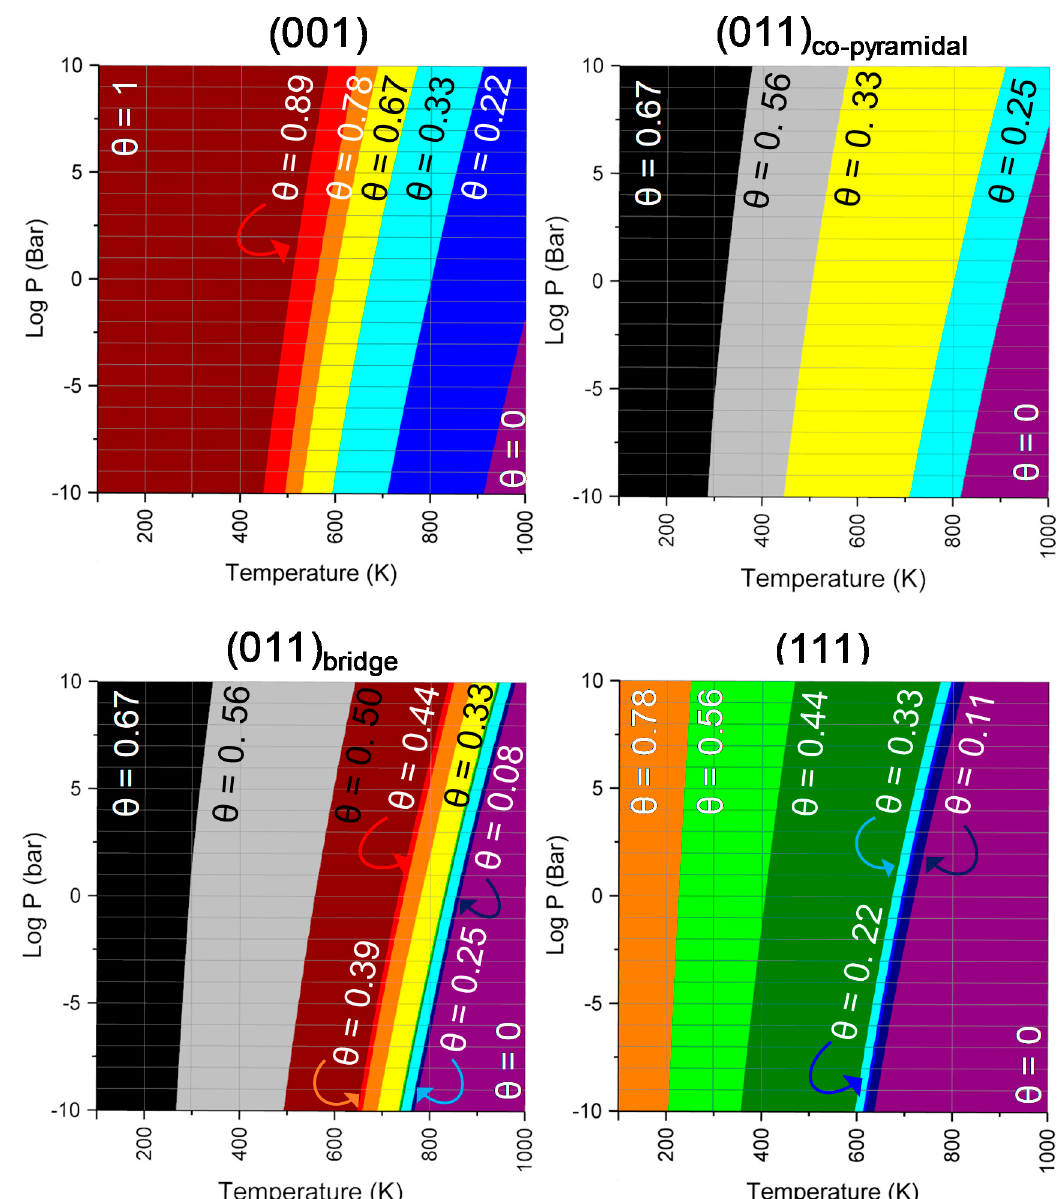
Figure 7. Surface phase diagrams in terms of pressure and temperature for the Pt (001), (011), and (111) surfaces.